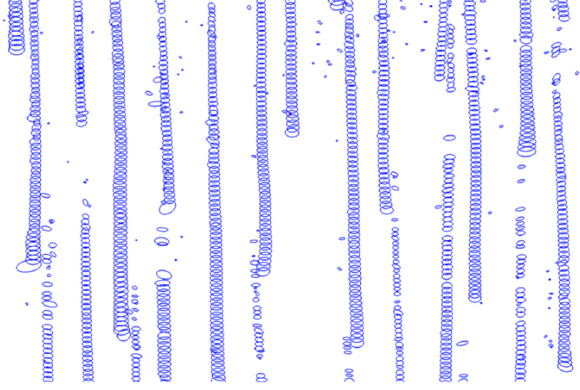
Figure 11. Ellipses detected from point-clouds.